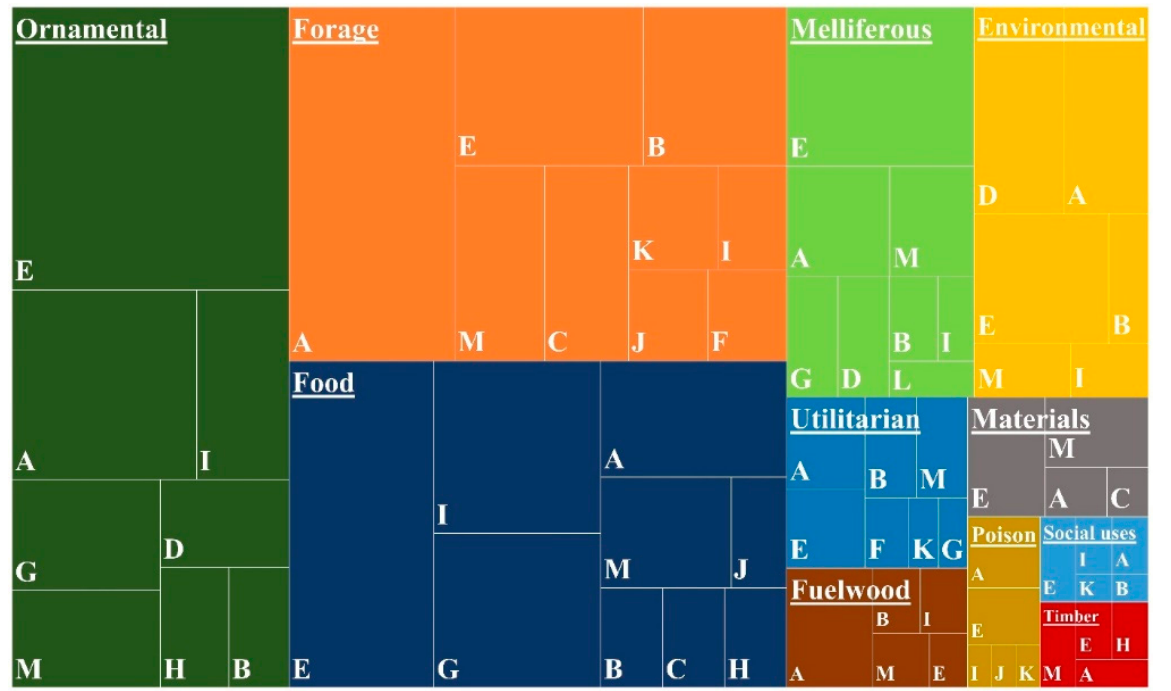
Figure 6. Relationship between taxa uses and biogeographic origin. The areas of the polygons are proportional to the number of taxa. ( A ): Afrotropical; ( B ): Afrotropical and Oriental; ( C ): Afrotropical, Oriental and Austral (optional); ( D ): Austral; ( E ): Neotropical; ( F ): Neotropical, Afrotropical, Oriental and Austral (optional); ( G ): Oriental; ( H ): Oriental and Austral; ( I ): Palaearctic; ( J ): Palaearctic and Afrotropical; ( K ): Palaearctic, Afrotropical, Oriental, and Austral (optional); ( L ): Nearctic; ( M ): Other. Notes: Afrotropical (includes Afrotemperate region); Austral (includes one or more of the Neoguinean, Australotemperate and Neozelandic regions); Neotropical (includes Andean region).